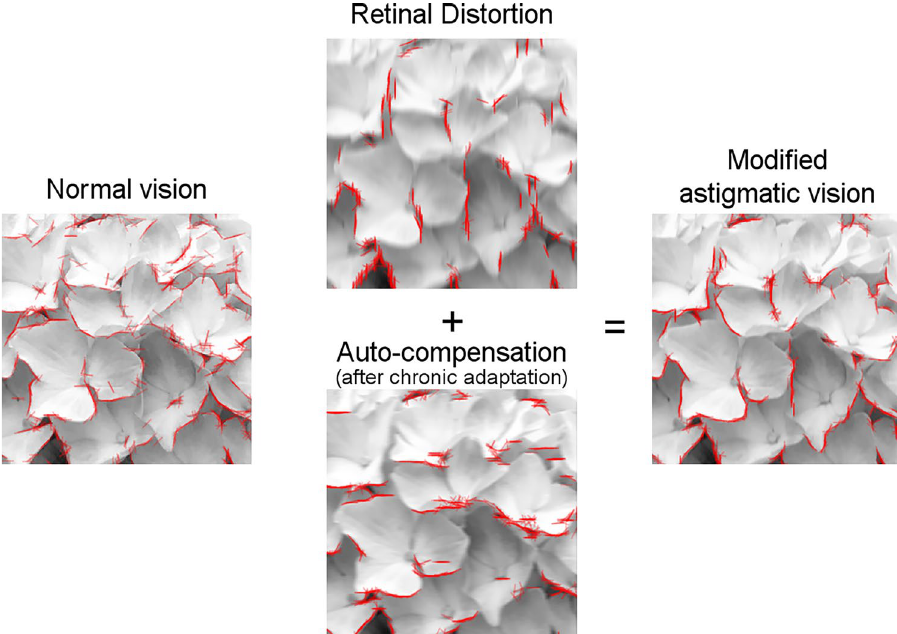
Figure 1. Simulation of the compensatory effect on chronic astigmatism when an image of a hydrangea is presented. The effect of the astigmatic blur and the automatic compensation were simulated for visualization purposes, according to the mechanisms of the adaptation model described in the Results and Methods sections. The edges of each image were detected with the Sobel operator (red). The edges are intact in the image of normal vision but severely biased vertically in the astigmatic retinal image. After being counterbalanced by the inversely biased edges of the automatic compensation, the vision with chronic astigmatism partly restores the original